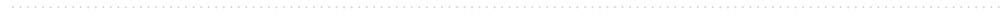
Figure 3. Image alignment. Three representative outputs of the aligned image processes. Upper: A pair of images at different time points of three patients (P1–P3). Lower: Aligned images. We used the FAST corner detection and BRIEF features. The transformation matrix was estimated from the corresponding points by RANSAC estimation. The images were aligned (parallel translation, scaling, rotation, and skew) by an affine